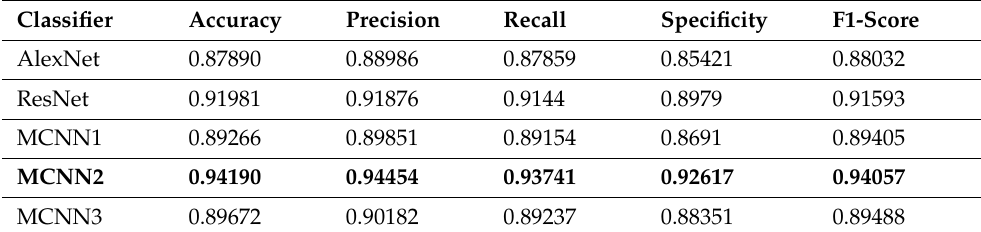
Table 5. Classification results using denoised image